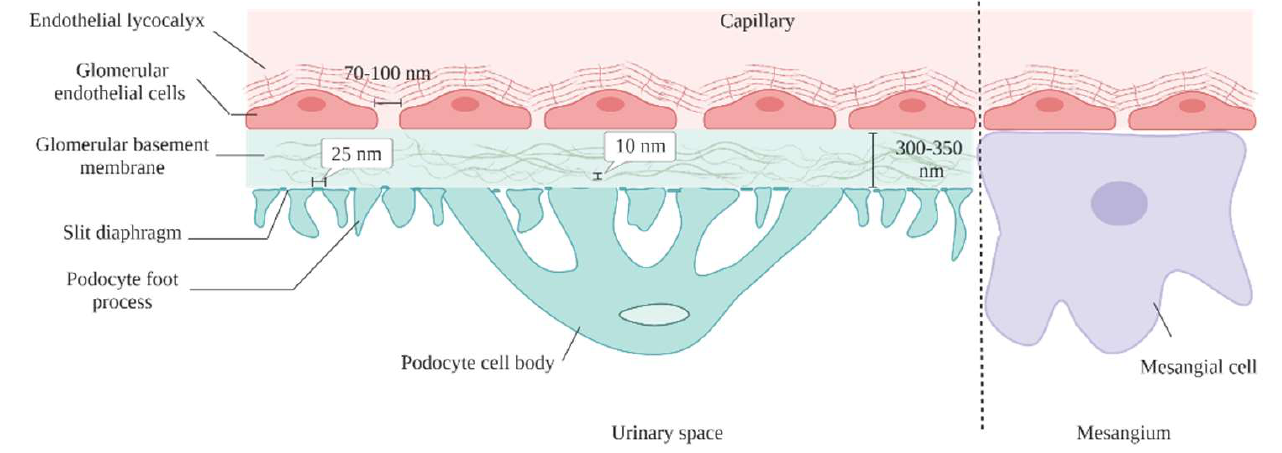
Figure 4. Schematic presentation of the glomerular filtration barriers.